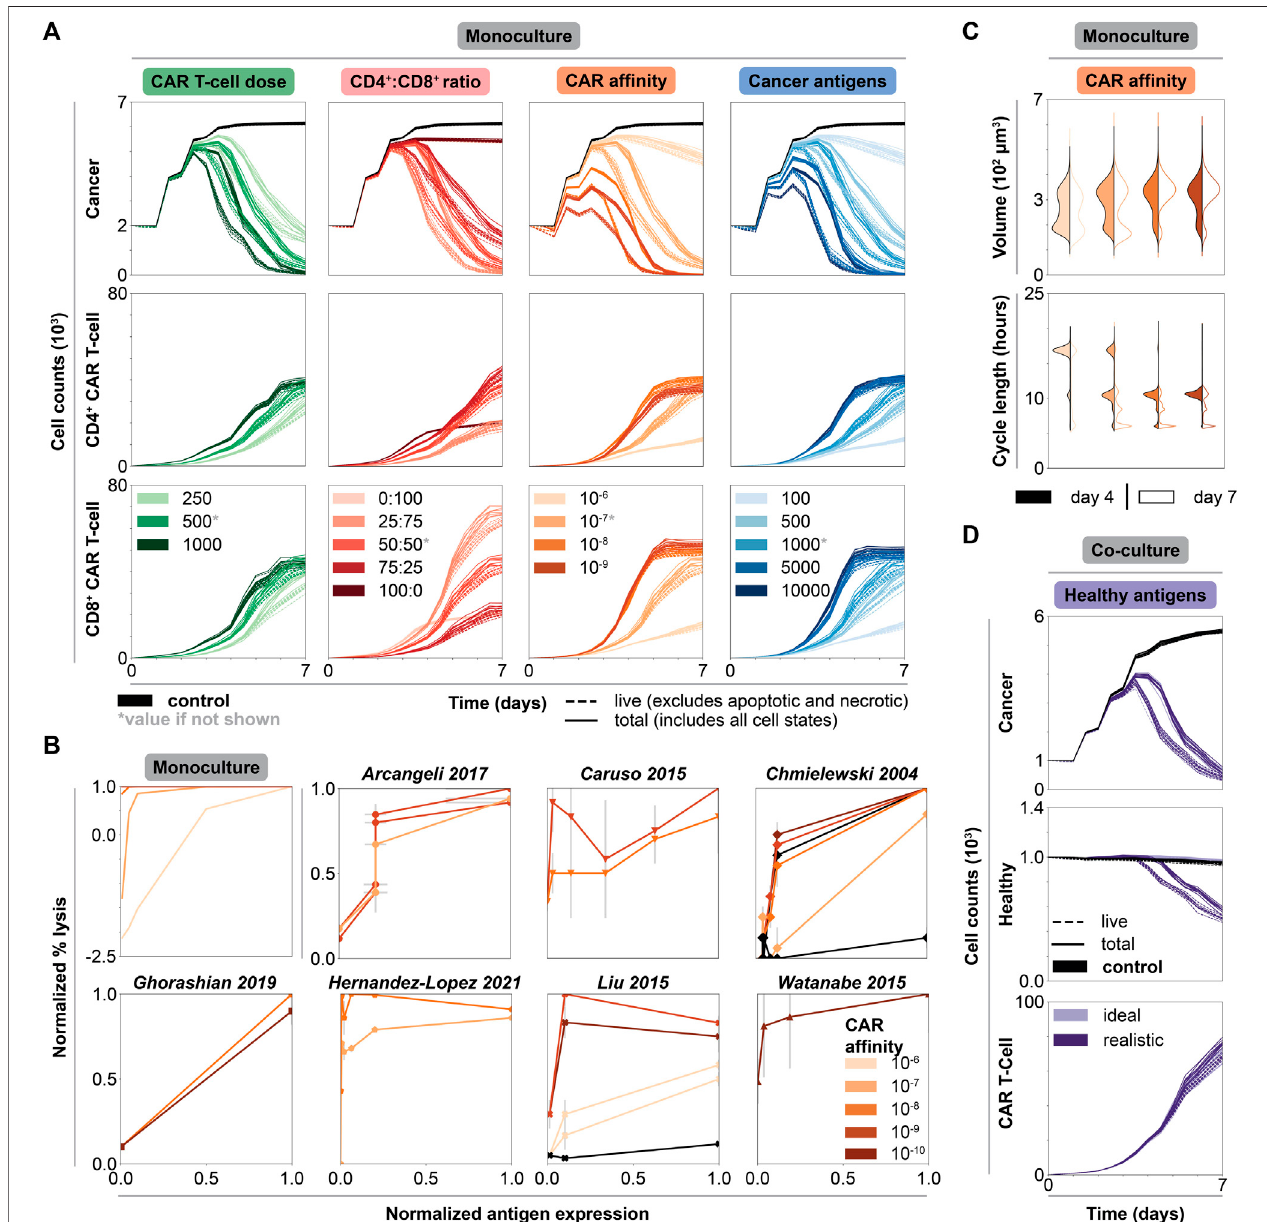
FIGURE 2 | Impact of individual CAR T-cell and tumor features on cytotoxicity and CAR T-cell growth in dish . (A) Cell counts over time of untreated (black) and treatedconditions(gradedhues)holdingallbutonefeatureconstant.Eachcolumnshowstheaxisbeingchanged,whereallotherfeaturesareheldconstantatindicated intermediate values (indicated by asterisk, CAR T-cell dose = 500 CAR T-cells, CD4 + :CD8 + ratio = 50:50, CAR af fi nity = 10 − 7 M, cancer antigens = 1000 antigens/cell), whilerows show the cell type being plotted. (B) Normalized percent lysis curves for in silico and published experimental in vitro data. Plot for simulated data shows percent lysis for each set of CAR af fi nity values across normalized cancer antigen values. All other axes were held constant, and the data were averaged across replicates. Simulations with negative percent lysis indicate cancer cell growth. Experimental data — representing an array of CAR types, effector to target (E:T) ratios, ICDs, and cancer cell lines ( Supplementary Table S6 , Supplementary Data S5 ) — were normalized to maximum percent lysis and antigen levels with estimated error bars. The plots show percent lysis for each set of CARs tested per paper, each with unique CAR af fi nity and tested across a range of antigen target values. (C) Volume and cell cycle distributions for CAR T-cell populations at t = 4 d ( fi lled) and t = 7 d (outline) holding all but CAR af fi nity constant at an intermediate value in monoculture. LegendisconsistentwithpanelB.Thedataforcancercellpopulationsandforallotherfeaturescanbefoundinthe SupplementaryMaterial . (D) Cellcountsovertime of untreated (black) and treated conditions (graded hues) holding all features constant at an intermediate value. Legend is consistent with panel B for both ideal and realistic co-culture. Solid lines represent total cell counts, dashed lines represent live cell counts.